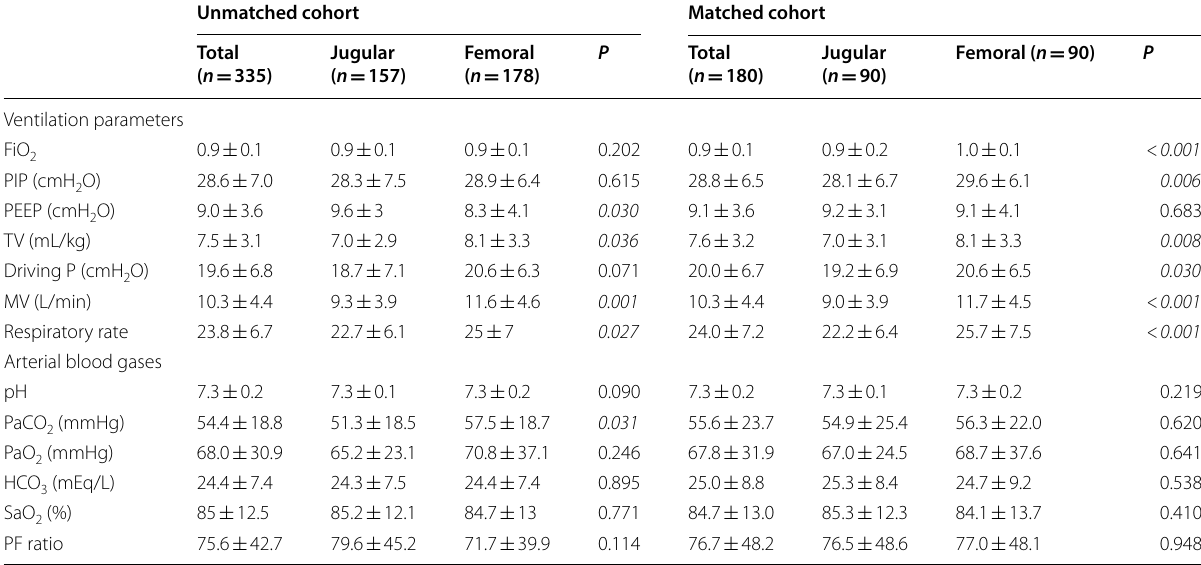
Values are expressed as mean